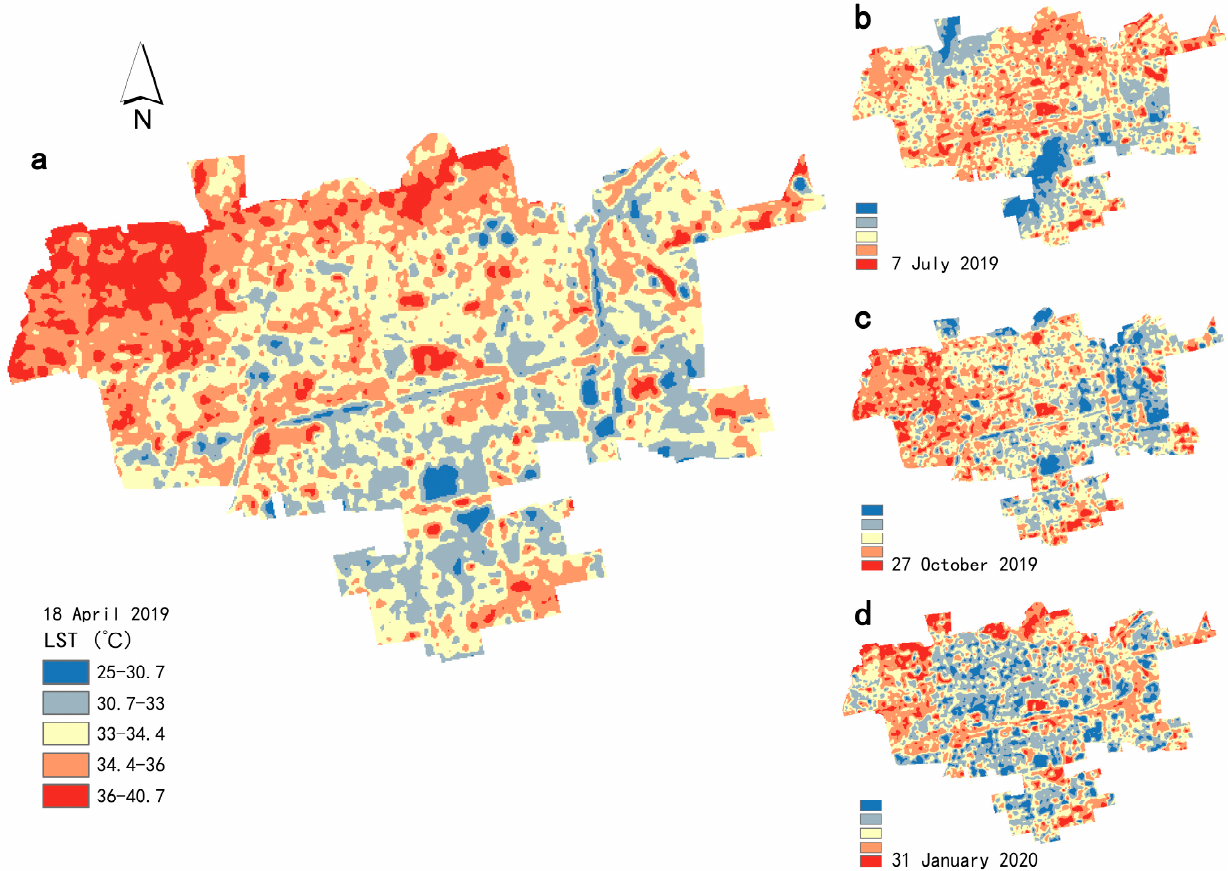
Figure 4. Land surface temperature: ( a ) LST in spring; ( b ) LST in summer; ( c ) LST in autumn; ( d ) LST in winner.